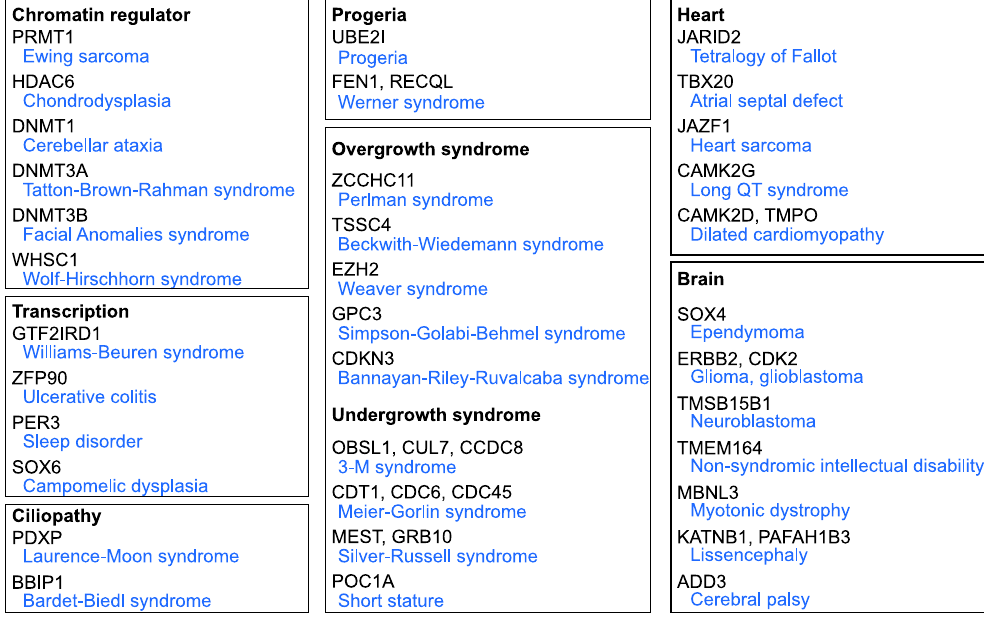
Figure 7. Associations of the common JAGs to the human genetic diseases. Biological categories of the genes and their associated human genetic diseases. All the common JAGs were searched for their association with human genetic